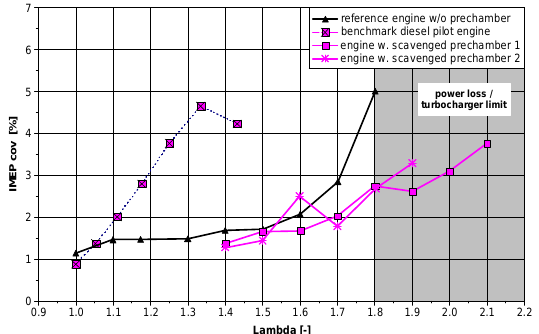
Fig. 15. Cyclic variations for the operating point 2 (2000 rpm/220 Nm)